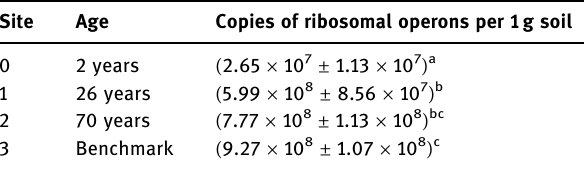
Table 2: Bacterial abundance in study sites assessed by real - time PCR. Numbers express means with standard errors for the amount of copies of ribosomal operons per 1 g of soil. Di ff ering superscript letters ( a – c ) indicate signi fi cant di ff erences between sampling sites ( p < 0.05